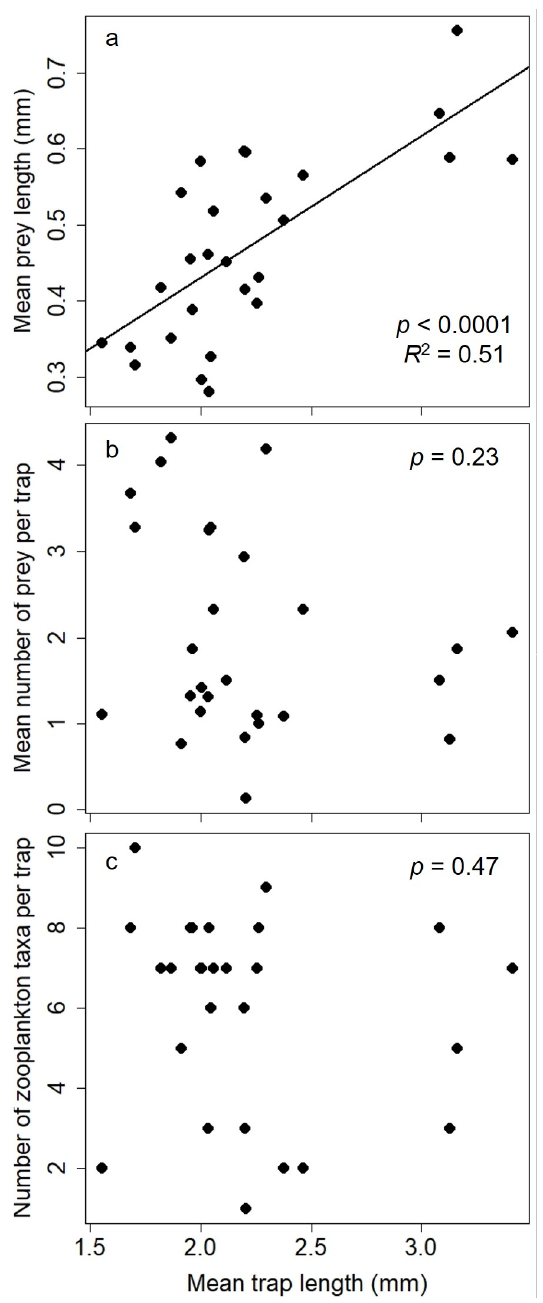
Figure 2. Relations between mean trap length and ( a ) mean prey length, ( b ) mean number of prey per trap, and ( c ) number of zooplankton taxa per trap; n = 27 for each analysis. A significant difference existed in the PDD of the broad zooplankton groups in traps (Kruskal–Wallis: H = 44.79; p < 0.0001; Figure 3a). Dominance by Cladocera in traps was greater than dominance by copepods, mites, or ostracods ( p ≤ 0.0003); cladoceran taxa comprised 55 ± 23% of the broad zooplankton community dominance across traps. Ostracods ( p = 0.02) and copepods ( p = 0.04) were more dominant in traps compared to mites, but no difference existed in the PDD of ostracods or copepods in traps ( p = 1.00). Ostracods comprised 22 ± 25% of the diet items in traps (Figure